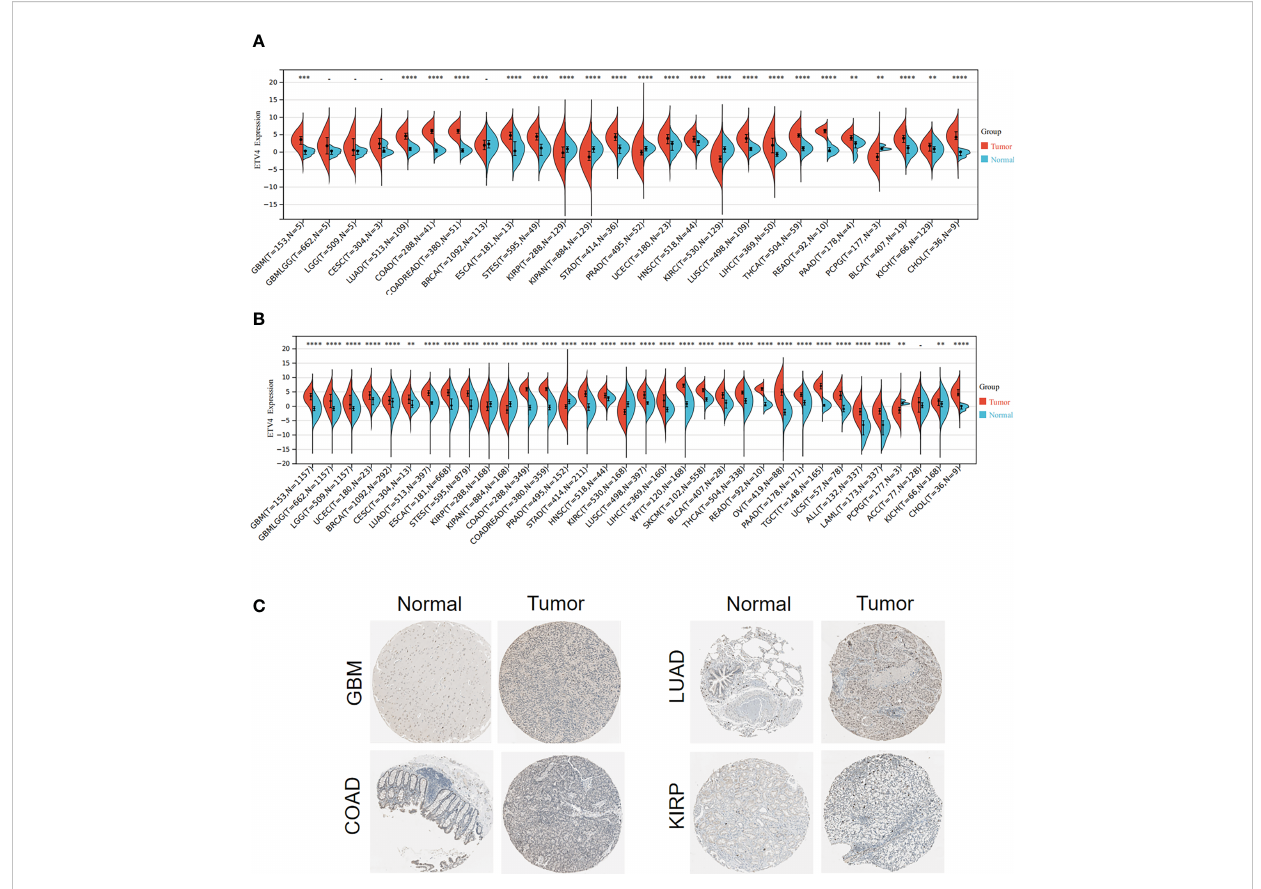
FIGURE 1 ETV4 expression in various human tumors. (A) mRNA levels of ETV4 among different tumors and adjacent normal specimens using TCGA data. (B) mRNA levels of ETV4 in tumors and normal tissues using the combined data from TCGA and GTEx. (C) Protein expression levels of ETV4 in tumors and their corresponding normal tissues based on The Human Protein Atlas. "-" :no statistic difference **p < 0.01; ***p < 0.001; ****p <